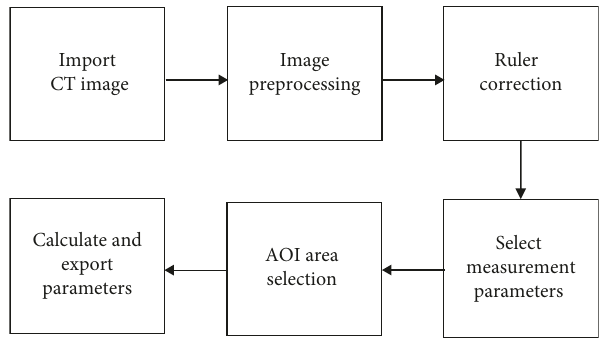
Figure 2: Image processing flow chart based on IPP.